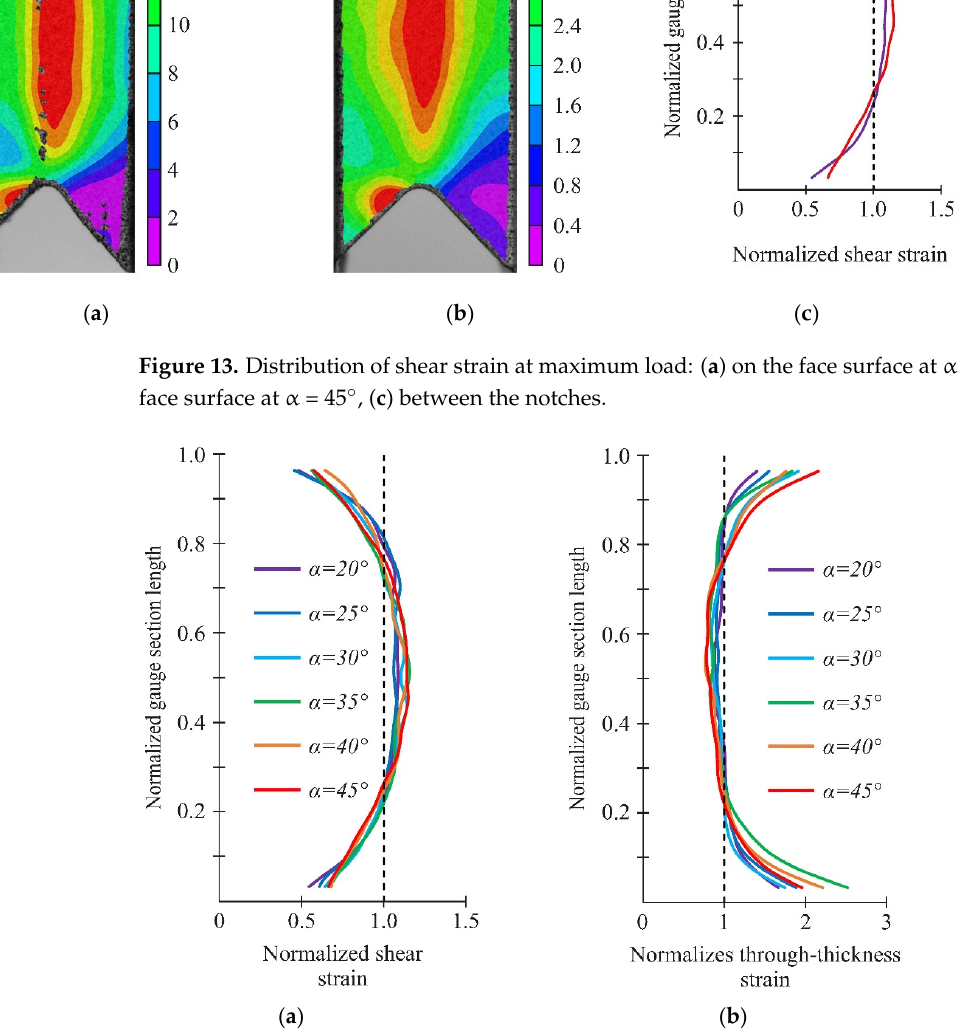
Figure 14. Distribution of interlaminar shear ( a ) and through-thickness ( b ) strains at the loading angles α = 20°–45°. angles α = 20–45 ◦